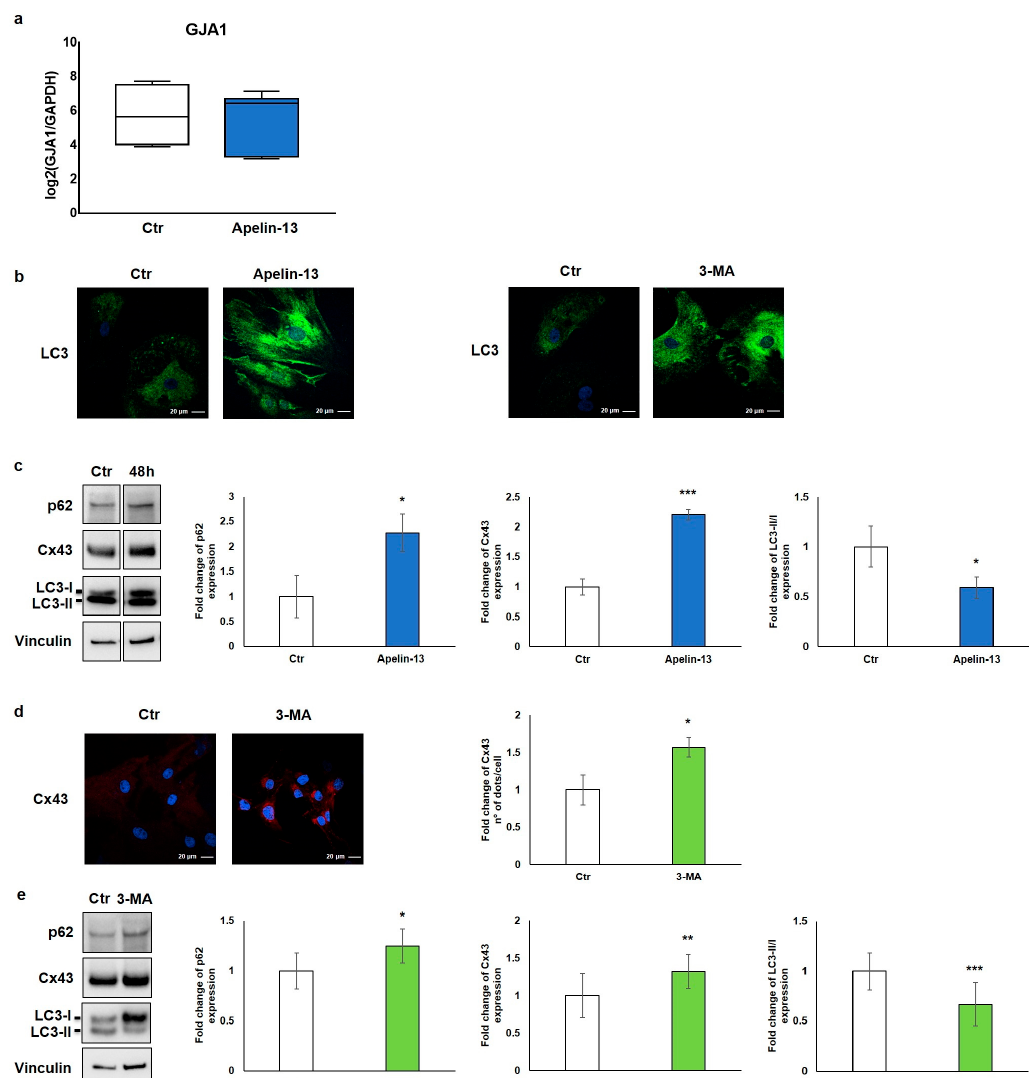
Figure 3. Apelin-13 increases Cx43 protein levels through autophagy inhibition. ( a ) Quantitative real-time PCR of GJA1 gene in NMCs untreated or treated with Apelin-13 ( n = 3). ( b ) Qualitative immunofluorescence evaluation of LC3 expression in Apelin-13- and 3-MA-treated NMCs vs . Ctr cells. LC3 was stained using anti-LC3 antibody (green), and cell nuclei were visualised using Hoechst (blue). Images were acquired by confocal laser microscopy at 63 × , scale bar 20 μ m. ( c ) Western blot analysis of p62, Cx43, and LC3 protein expression in NMCs after Apelin-13 treatment (100 nM, 48 h). Quantitative evaluation of band intensity was expressed as fold change of Apelin-13-treated NMCs vs . Ctr cells. Vinculin served as internal control (mean ± SEM; * p ≤ 0.05; *** p ≤ 0.001; n = 4). ( d ) Immunofluorescence analysis of Cx43 protein expression in 3-MA-treated NMCs (5 mM, 16 h). Cx43 was stained with anti-Cx43 antibody (red), and cell nuclei were visualised using Hoechst (blue). Images were acquired by confocal laser microscopy at 63×, scale bar 20 μ m. Quantitative evaluation of dots/cell intensity was expressed as fold change of 3-MA-treated NMCs vs . Ctr cells (mean ± SEM; * p ≤ 0.05; n = 3). ( e ) Western blot analysis of p62, Cx43, and LC3 protein expression in NMCs after 3-MA treatment. Quantitative evaluation of band intensity was expressed as fold change of 3-MA-treated NMCs vs . Ctr cells. Vinculin served as internal control (mean ± SEM; * p ≤ 0.05; ** p ≤ 0.01; *** p ≤ 0.001; n = 3).